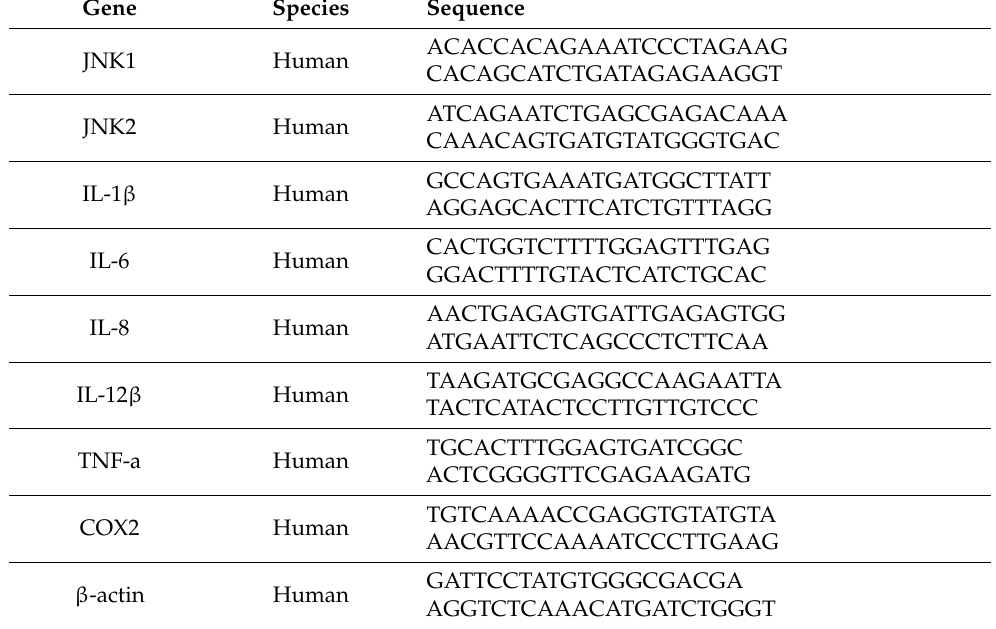
Table 1. Primer sequences for